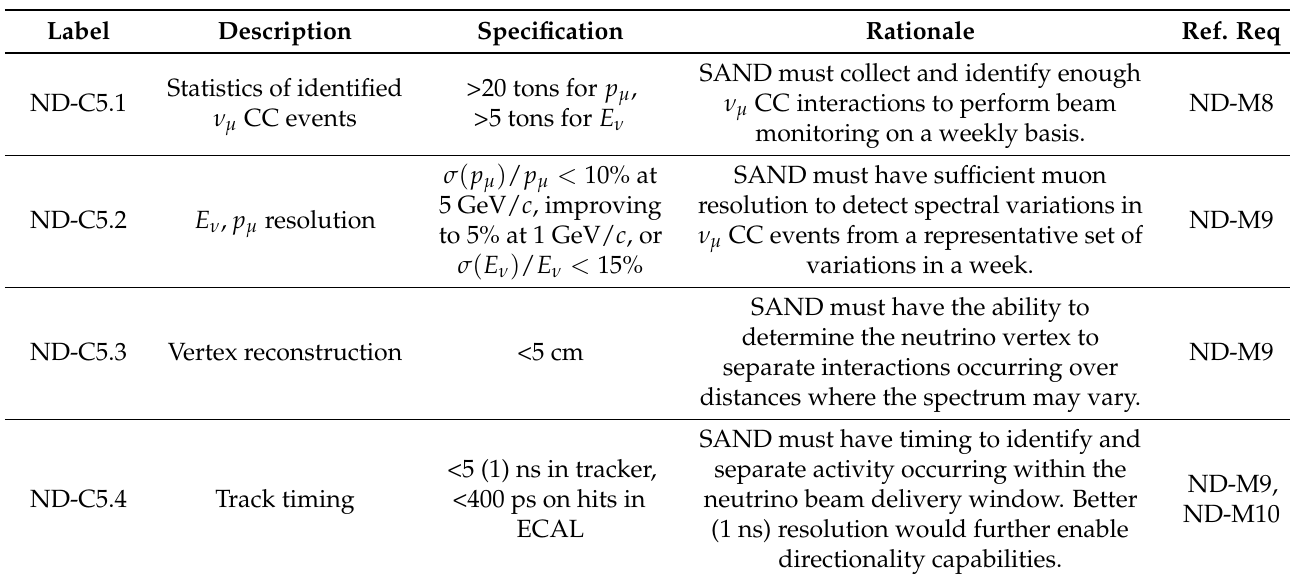
Table 8. Capability requirements for